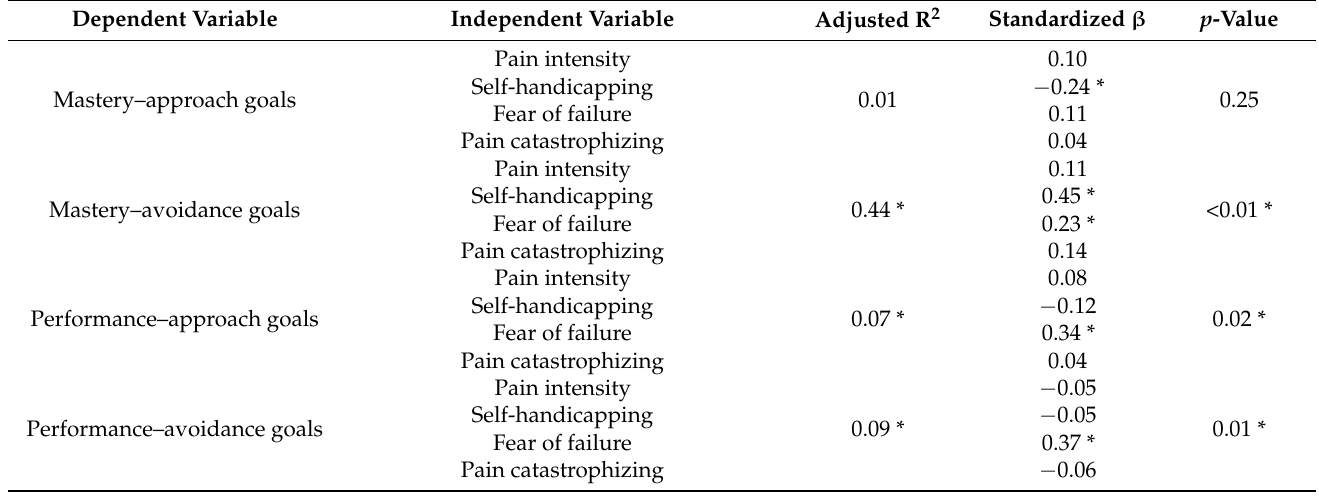
Table 4. Multivariate regression analyses in young elite athletes with and without chronic pain predicting goal orientations. Dependent